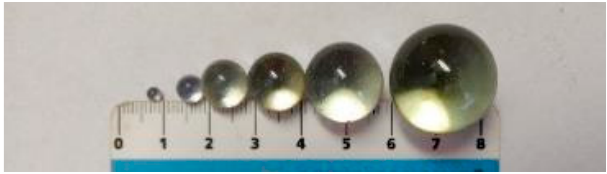
Figure 1. Used technical glass